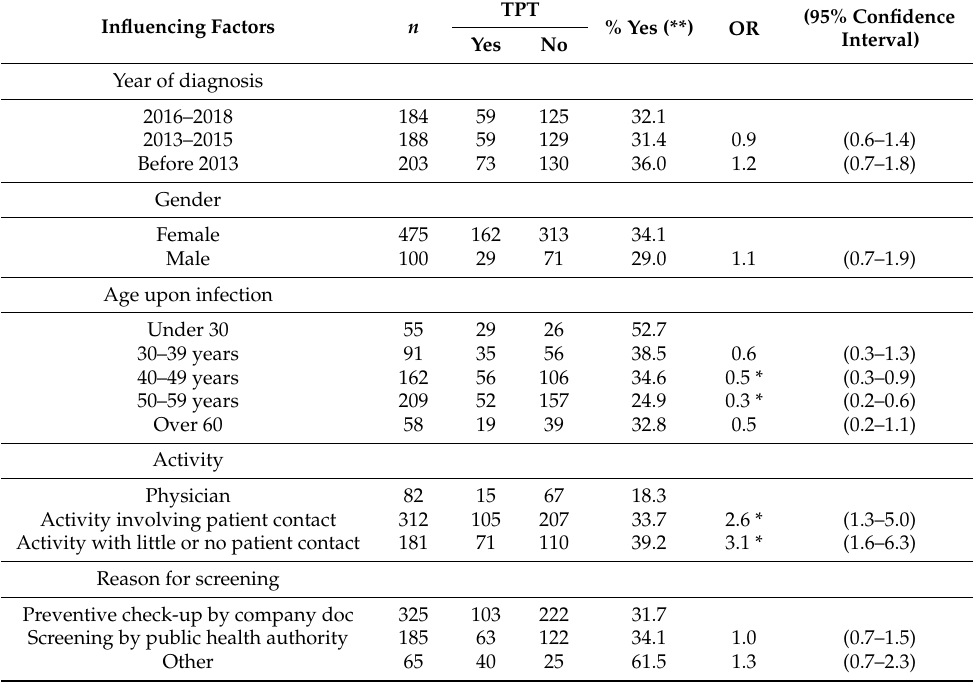
Table 4. Factors influencing the use of TPT from the surveys ( n =